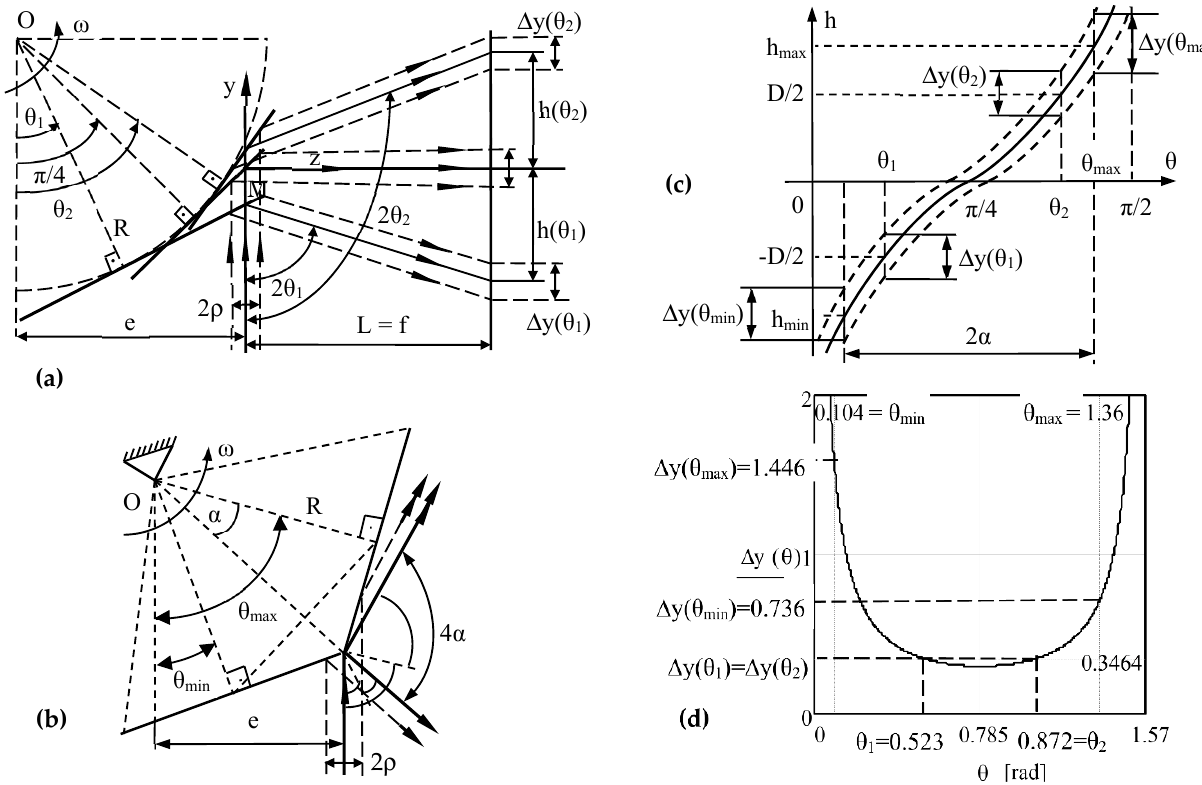
Figure 8. ( a ) Reflection of a laser beam (of finite diameter 2 ρ ) on a PM facet for θ = θ 1 , π /4, and θ 2 — as considered in Figure 2b for the axis of the beam; ( b ) reflection of the laser beam at the beginning and end of a PM facet. ( c ) The scanning function for the entire beam—generalized case of Figure 3(b1), with ( d ) the variation Δ y ( θ ) of the spot on a direction perpendicular to the O.A.